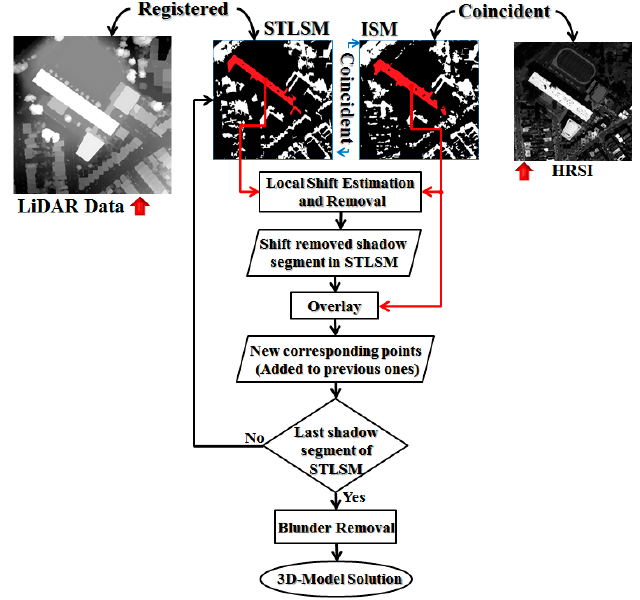
( b ) Figure 16. Displacement vectors obtained from the fine 2D model and the result of the matching between the ISM and STLAM: ( a ) 2D Displacements Map; ( b ) Compliance of the STLSM and ISM. Correction vectors ( Δ r, Δ c) were computed for a regular grid of points in PTLSM. For this reason the fitted polynomial of Equation (20) was applied. These vectors are depicted in Figure 16a. These vectors show the magnitude and orientation of the corrections in PTLSM. A comparison between Figures 14b and 16b reveals the significant improvement achieved in this section. 4.4. Coarse 3D-Model Estimation